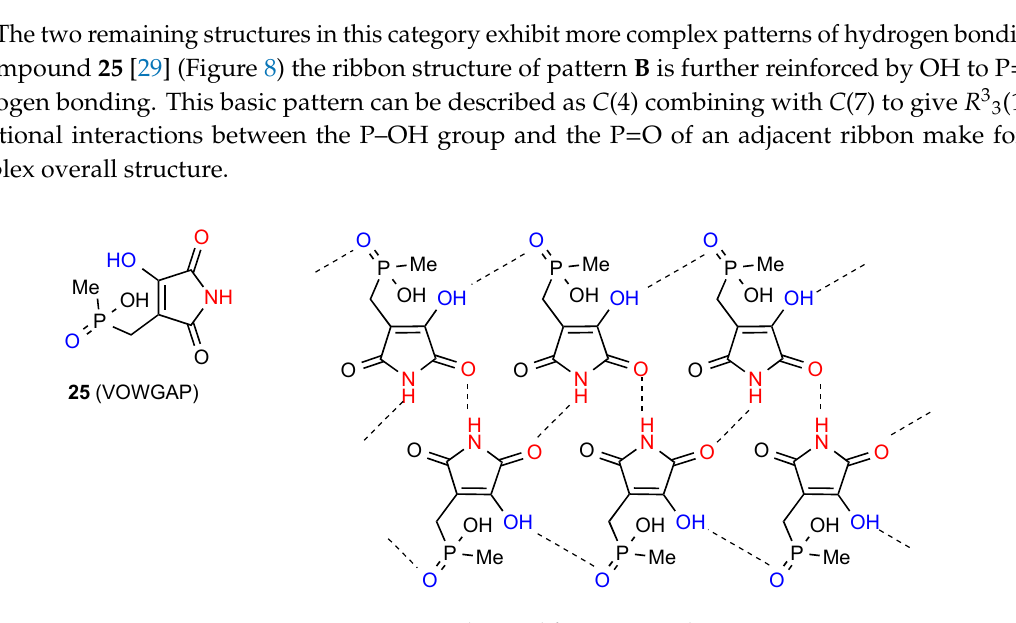
Figure 7. Disubstituted maleimides showing NH bonding to remote O or N acceptors.